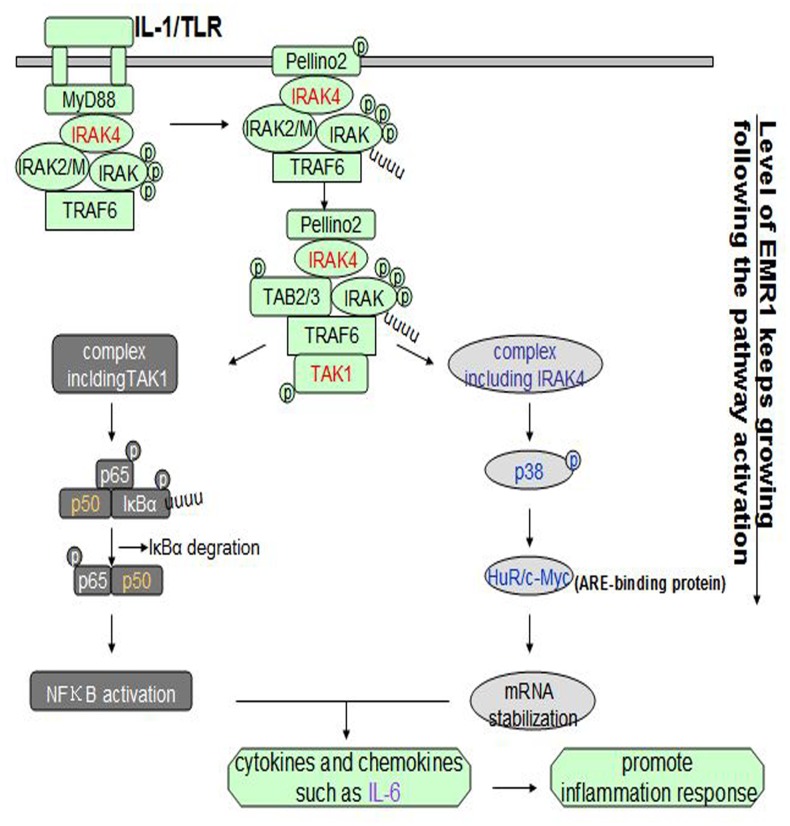
IL-1/TLR-induced NFκB signaling pathway.After the stimulation, IL-1R/TLR recruits adaptor molecule myeloid differentiation factor 88(MyD88) to their TIR domain, which further recruits and activates IRAK4. Then IRAK4, TRAF6 and IRAKs combine into a complex. After the coalition of Pellino2 and TAK1, the new complex is divided into at least two parts: complex including TAK1, activating NFκB through IκBα phosphorylation and degradation, and complex including IRAK4 which phosphorylates p38 and binds to the ARE-binding proteins like HuR and c-Myc. Two complexes both promote the release of cytokines and chemokines like IL-6 to further promote inflammation response. During the process EMR1 keeps growing.